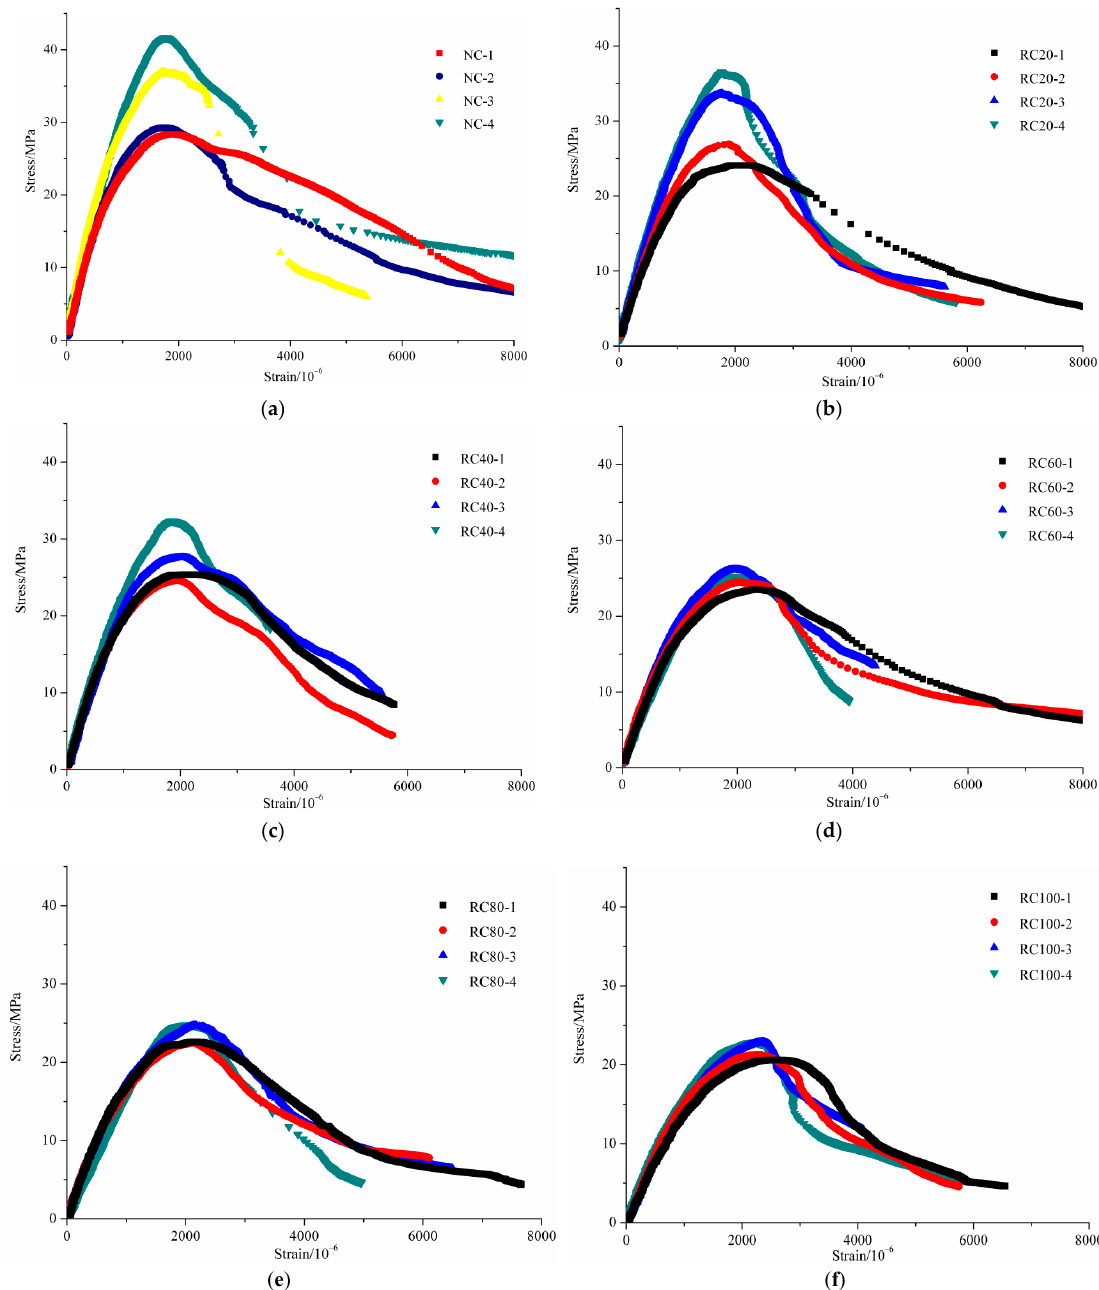
Figure 10. Stress–strain curves for NAC and RAC: ( a ) NAC, ( b ) RC20, ( c ) RC40, ( d ) RC60, ( e ) RC80 and ( f ) RC100.